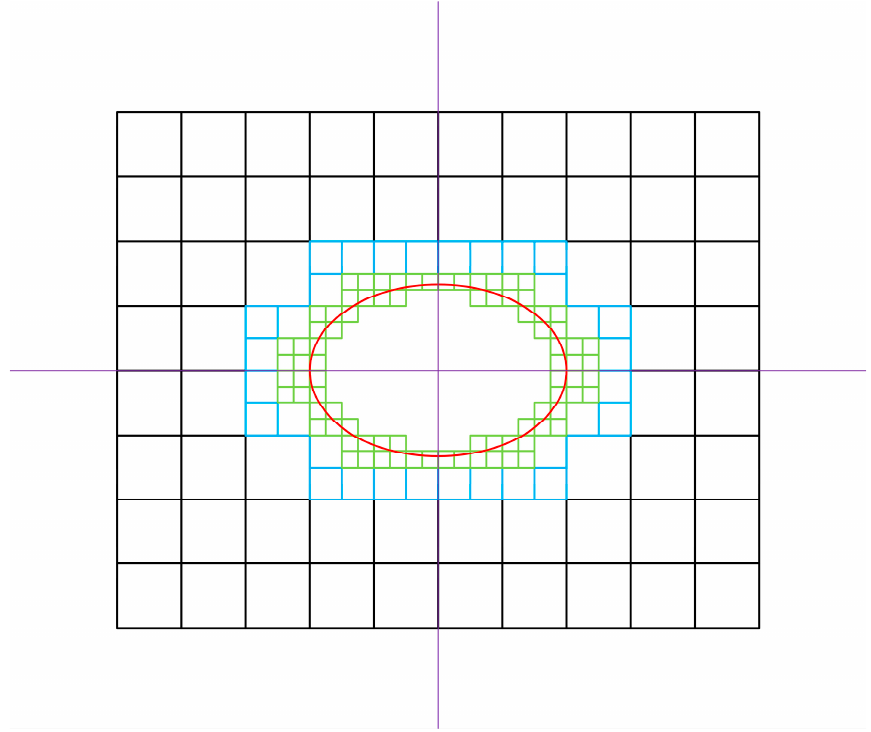
Figure 8. Example of a three-layer grid: the grid with a black frame is the first grid, the grid with a blue frame is the second grid and the grid with a green frame is the third grid. The red ellipse circle indicates the solid boundary in the flow field.